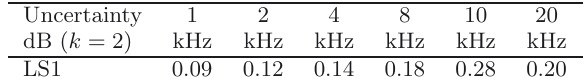
Fig. 7. Small an-echoic chamber designed for free-field reci- procity calibration by the Danish Primary Laboratory of Acoustics (DPLA). Total volume: 6 m 3 , inner volume: 1.7 m 3 density of glass wool: 90 kg/m 3 (not critical). The microphones being calibrated are mounted on displaceable rods to allow se- lection of the distance between the microphones. Prof. Knud Rasmussen in front of the room. Table 3. Typical uncertainty of a free-field response obtained by adding corrections to a pressure reciprocity calibration made by an experienced NMI. The numbers include correction uncertainties stated by IEC61094-7.